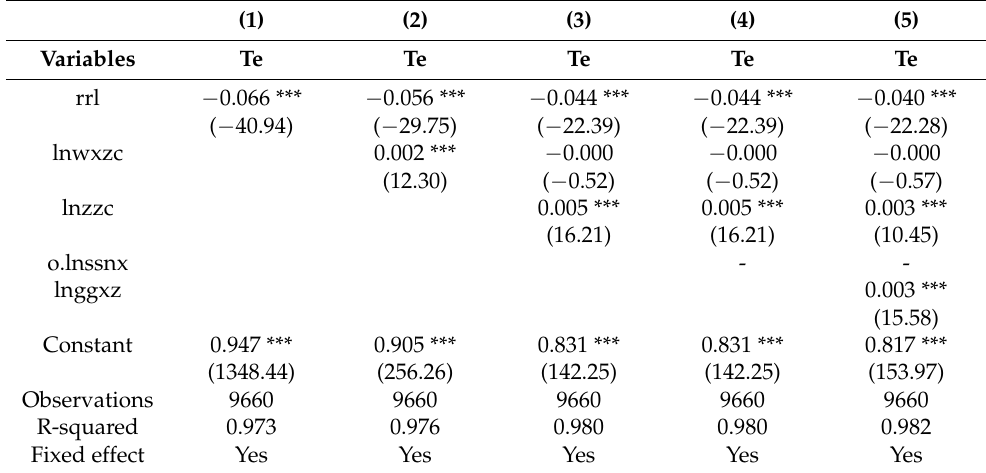
Table 4. Baseline regression results based on OLS